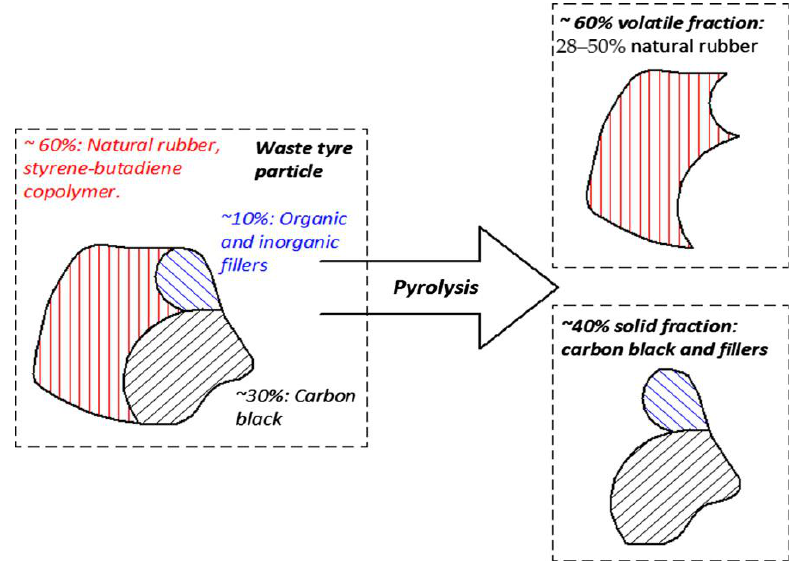
Figure 3. The scheme of WT pyrolysis [6] (Adapted with permission from Elsevier).